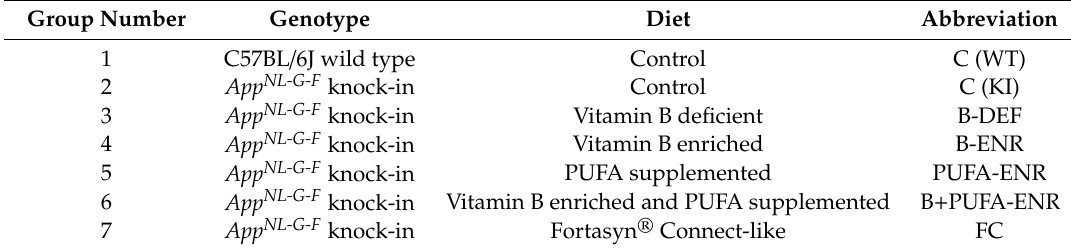
Table 1. Details of the experimental